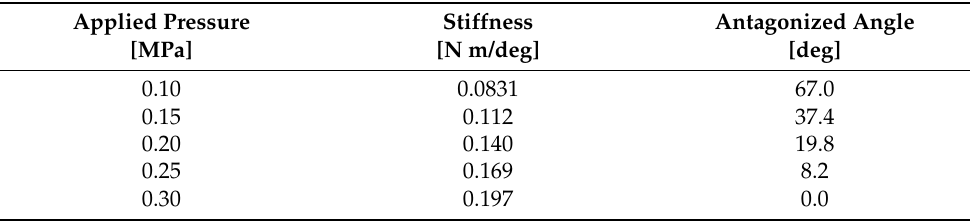
Table 2. Stiffness and antagonized angle of the one-sided spring antagonized joint [18–20].